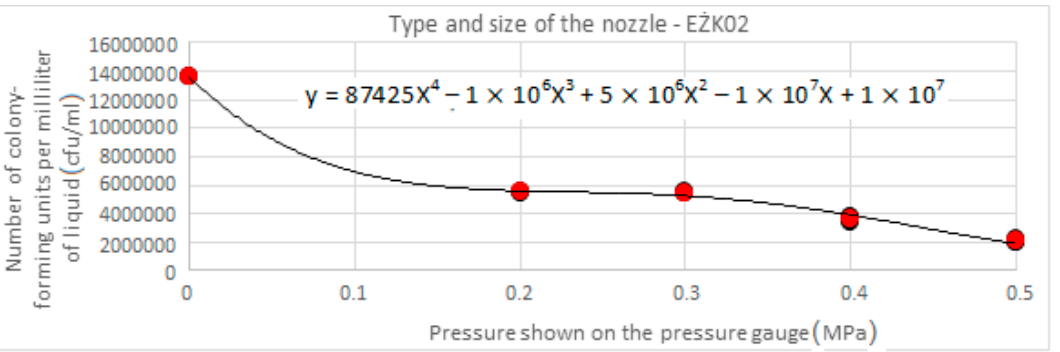
Figure 2. The influence of pressure on survival of cfu / mL of liquid for E ˙ZK02. The vertical axis shows the cfu / mL values, while the horizontal axis shows the pressure (MPa) values set in the throttling valve and read in manometers.